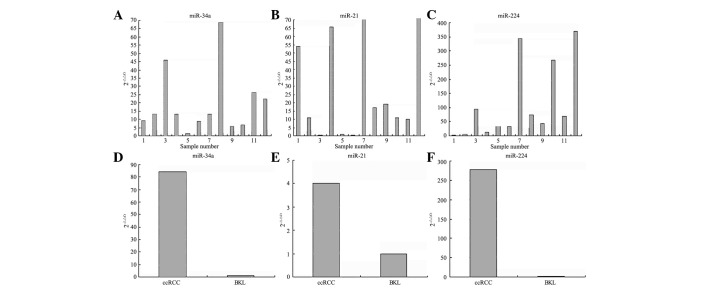
Individual (A, B, C) and general (D, E, F) relative quantification for miR-34a, miR-21 and miR-224 in serum samples from patients with ccRCC compared with those with BKL. ccRCC, clear cell renal cell carcinoma; BKL, benign kidney lesion.